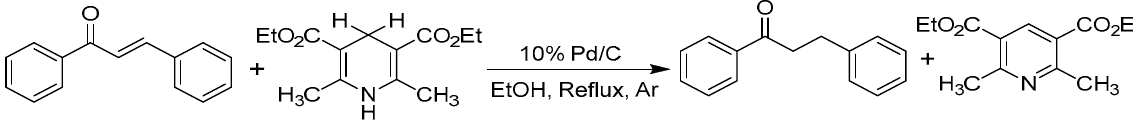
Figure 4. Hydricity of some typical hydride donors to release a hydride anion in acetonitrile.